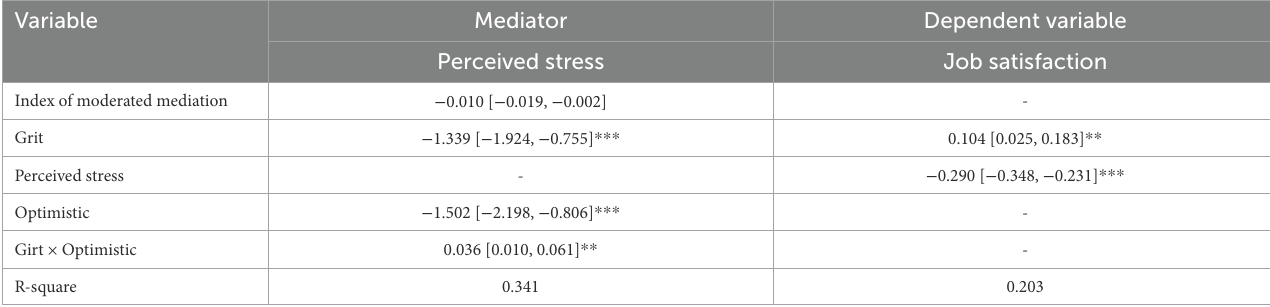
TABLE 4 Results of the moderated mediation model.